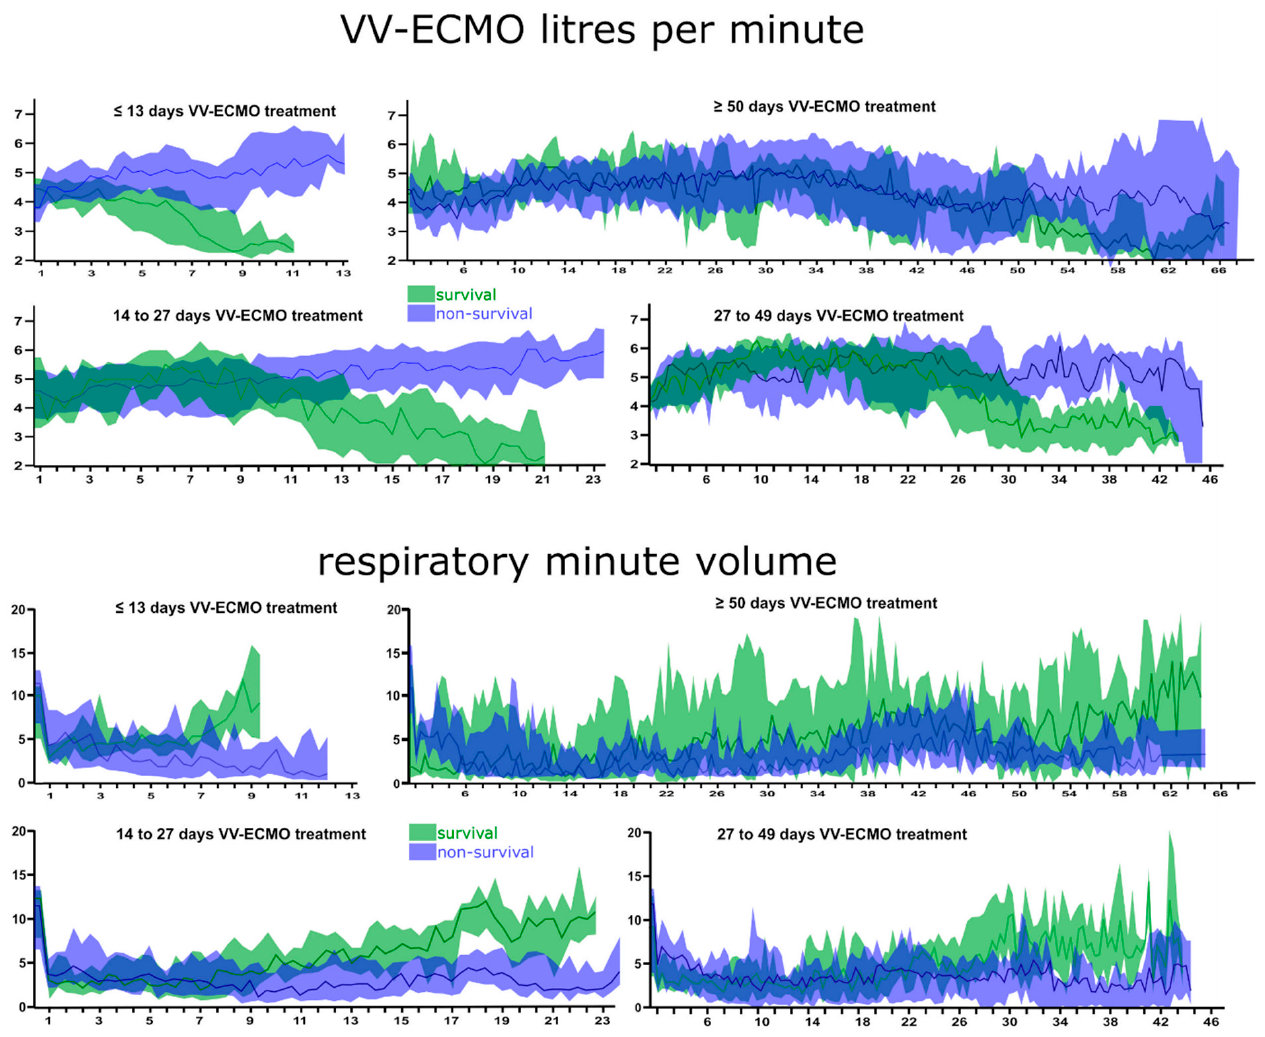
Figure 3. ECMO flow and respiratory minute volume over time separated by survival and grouped by treatment duration. Graphical visualization of the blood flow rates during VV-ECMO therapy and the respiratory minute volume over the course of the treatment days as median, including the corresponding interquantile range as coloured area.